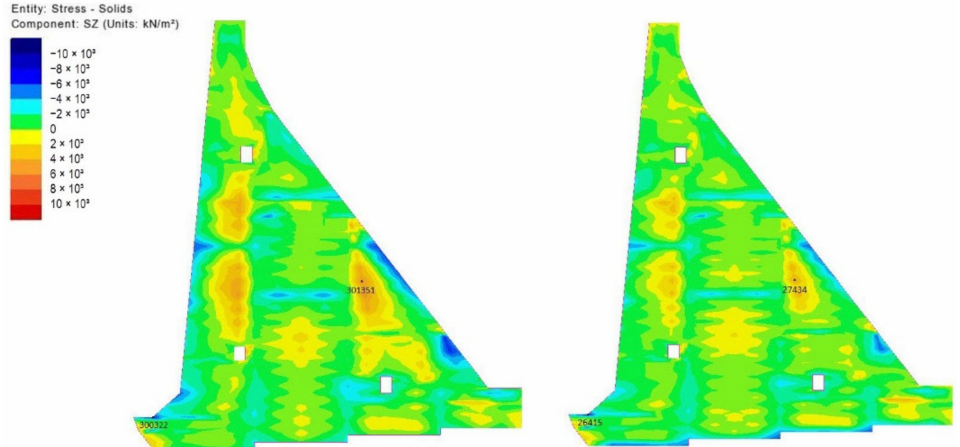
Figure 22. Stresses σ z in the mid-plane of the monolith 20 m long ( left ) and 15 m long ( right ) for the 1080th day (2nd of October of the fourth year); extremums: nodes 301,351 and 27,434.